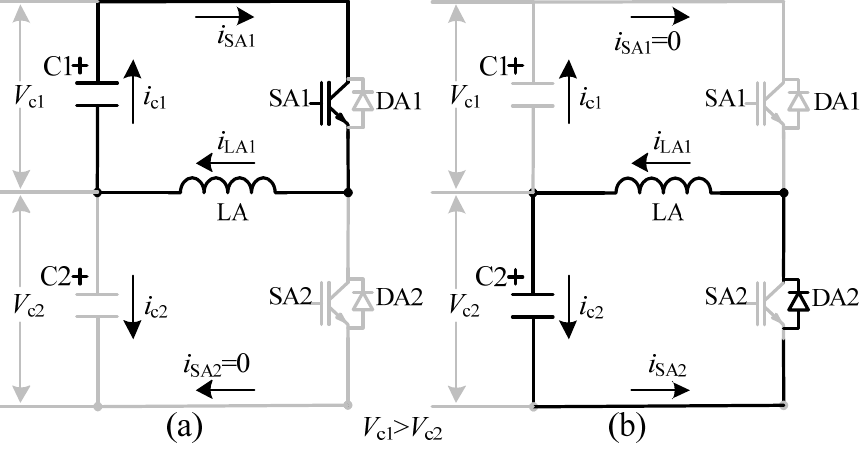
Figure 7. The inductance equalizing circuit of 3L-NPC. ( a ) Discharge current path from C1 to LA at V C1 > V C2 stage 1; ( b ) Charge current path from LA to C2 at V C1 > V C2 stage